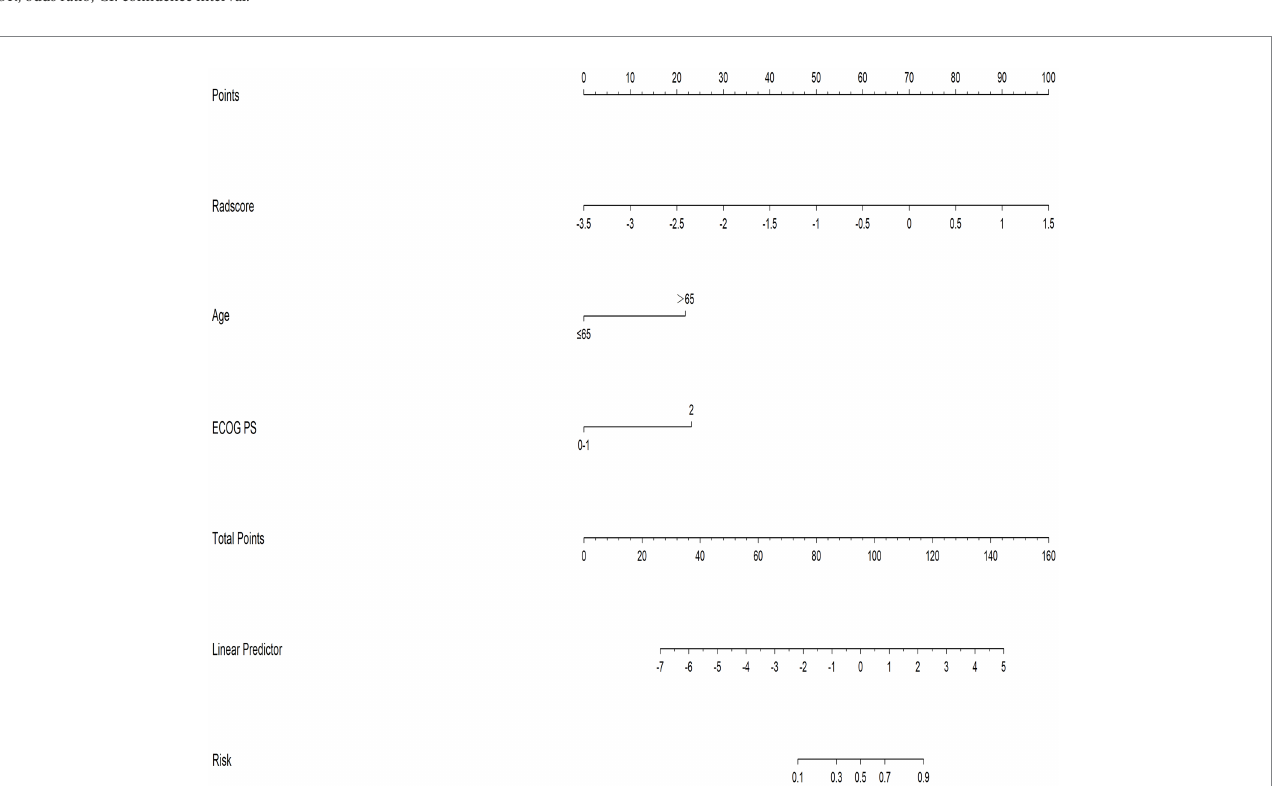
FIGURE 2 A nomogram prediction model integrated the rad-score and two clinical factors to detect malnutrition. The rad-score value is represented by the number. Every variable was located on the axis, and the corresponding point was obtained by drawing a straight line upwards to the points’ axis. The summation of all the points and identification of the location on the bottom line could be utilized to determine the estimated probability of malnutrition.